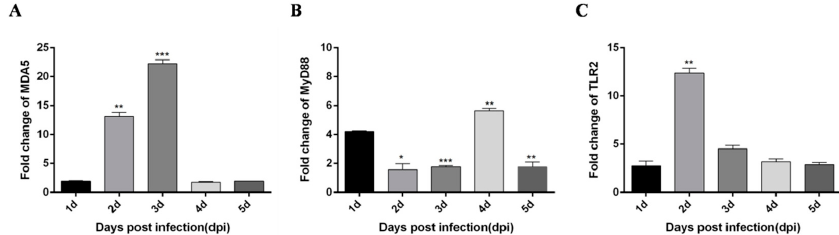
Figure 2. DTMUV-infected ducks effectively up-regulate MDA5, MyD88, TLR2 expression in the thymus. Each young SPF duck was challenged by intramuscular inoculation with DTMUV. ( A – C ) Thymus tissues of mock- and DTMUV-infected ducklings were collected at the indicated time points for examination of MDA5 ( A ), MyD88 ( B ), and TLR2 ( C ) mRNA expression using qRT-PCR. The average levels from three independent experiments are plotted. The error bars represent the SEs. * P < 0.05, ** P < 0.01.